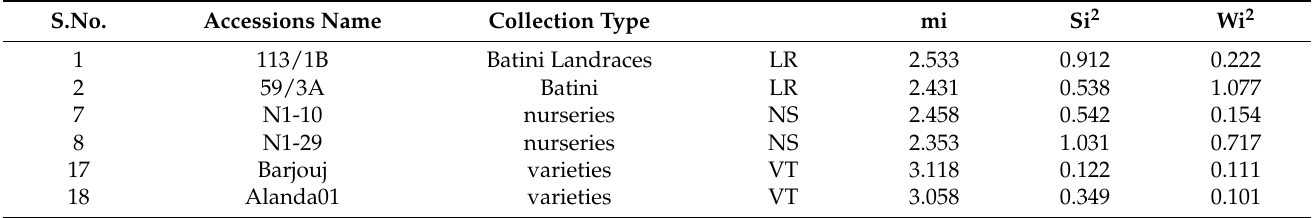
Table 9. Environmental variance ( S i 2 ) and Wricke’s ecovalence ( W i 2 ) over the saline treatment for the 6 barley genotypes with highest averaged mean yield across treatments